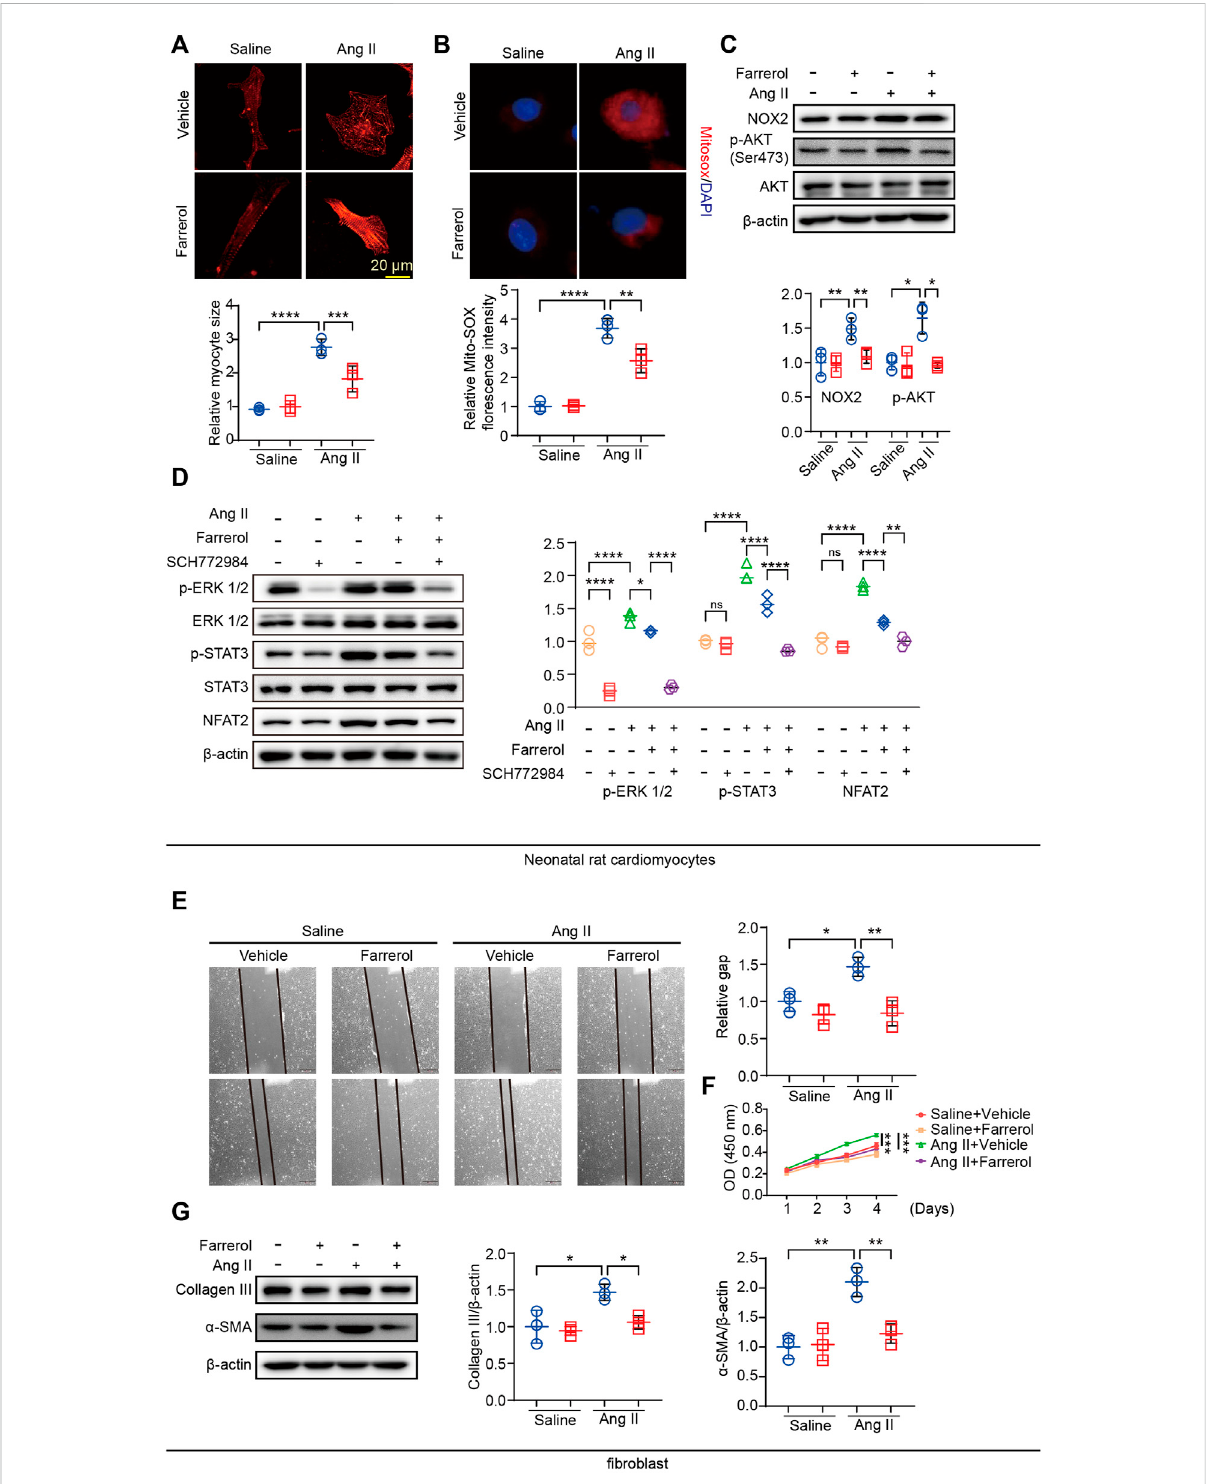
FIGURE 6 Farrerol inhibits Ang II-induced cardiac remodeling in vitro . (A) Representative images of Myocardial cells stained with α -actinin in each group andtherelativevalueofthestatistical chart; (B) Mitochondrial ROS levelsinNRVMsweredeterminedbyMitoSOX Redstaining; (C) Theexpressionof p-AKT (Ser473), AKT, NOX2 and β -actin detected by Western Blot; (D) The expression of p-ERK 1/2, ERK 1/2, p-STAT3, STAT3, NFAT2 and β -actin detectedbyWesternBlot; (E) themigrationability of fi broblastsby Wound scratchassay ineachgroup; (F) The proliferationability of fi broblasts was detected by CCK-8; (G) The expression of p-AKT (Ser473), AKT, NOX2 and β -actin detected by Western Blot (Salline = 3, Farrerol = 3, Ang II = 3, Ang II + Farrerol =